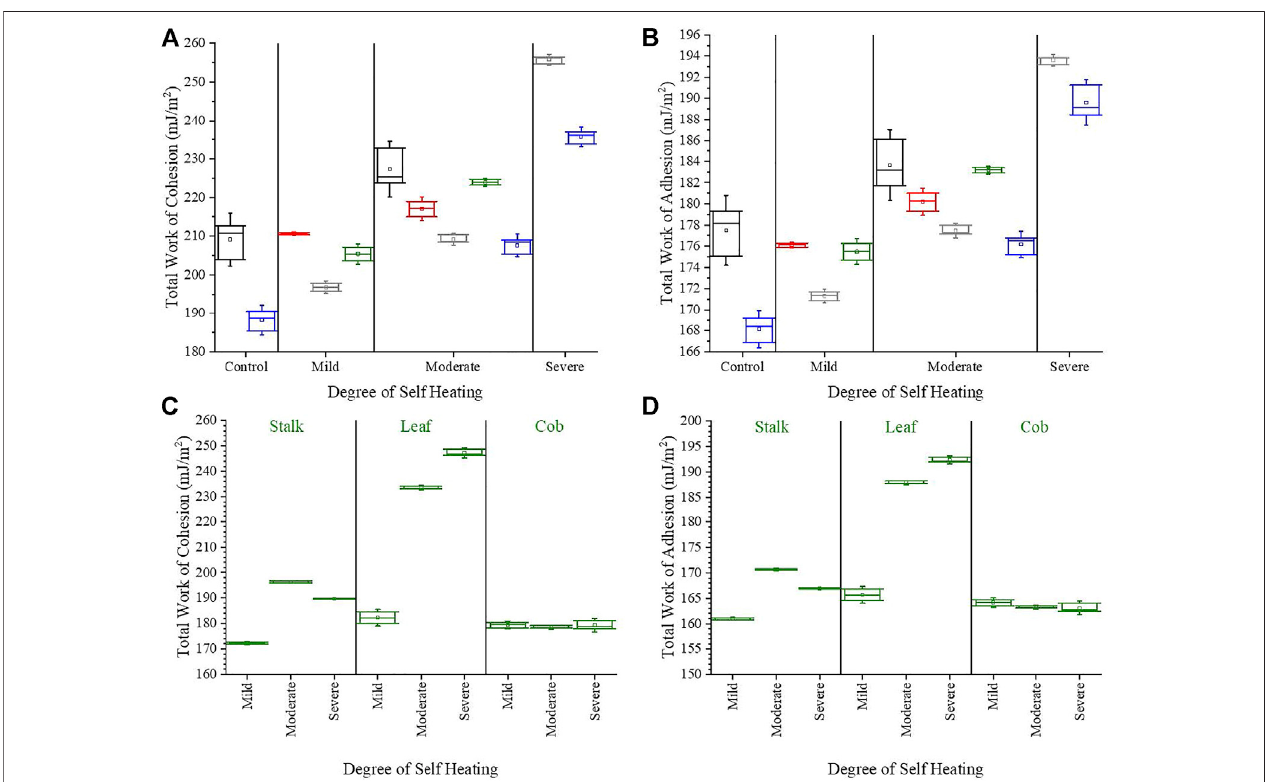
FIGURE 8 | (A) Work of Cohesion, (B) Work of Adhesion, of bulk bale samples; □ Bale 1, □ Bale 2, □ Bale 3, □ Bale 5, □ Bale 6. (C) Work of Cohesion (anatomical fractions), and (D) Work of Adhesion (anatomical fractions) with respect to degree of biological heating [box upper and lower limit = data max. and min., whiskers = sample standard deviation (Coeff. 1.5), solid horizontal line = median, hollow internal box = mean].